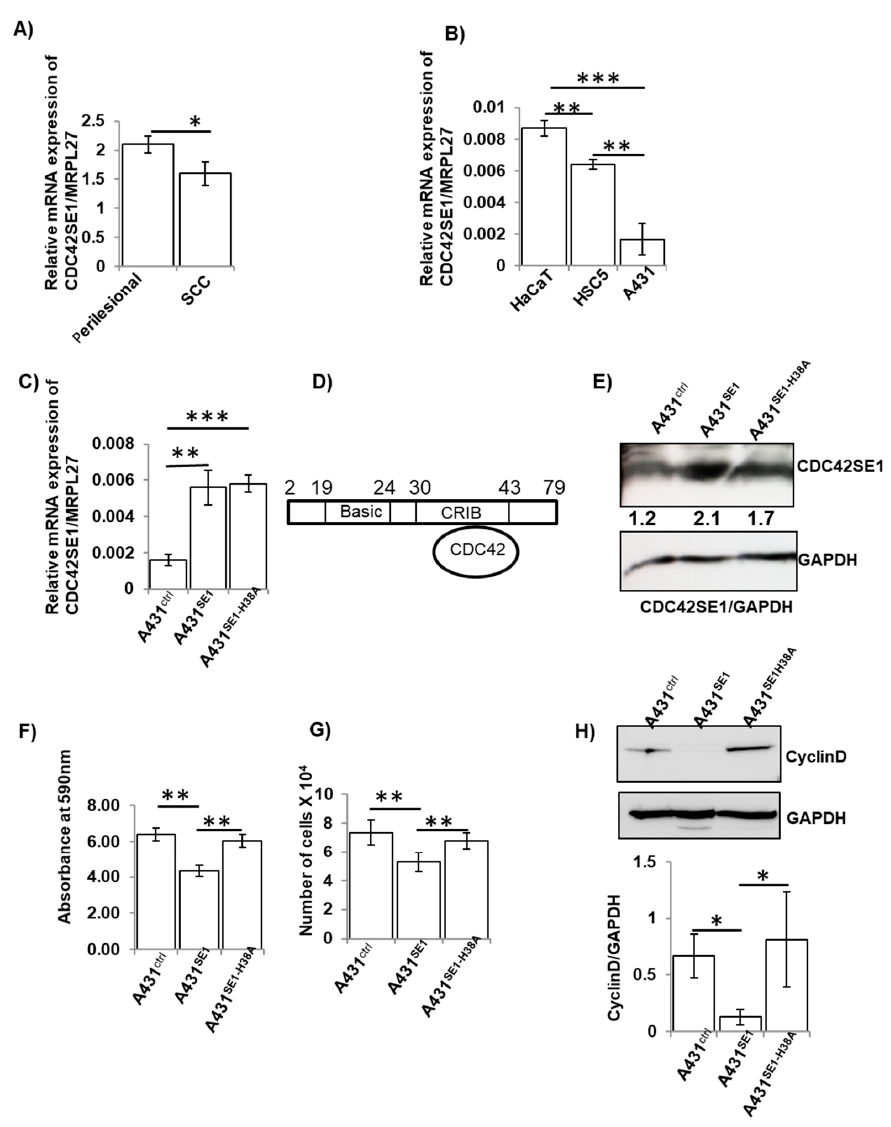
Figure 1. Expression of CDC42SE1 is reduced in SCC samples and exogenous expression of CDC42SE1 reduced cell proliferation. ( A ) Quantitative PCR analysis of expression of CDC42SE1 in SCC biopsies (n = 5) vs. the matched perilesional controls. Expression of MRPL27 was used to normalize. ( B ) Quantitative PCR analysis of expression of CDC42SE1 in HaCaT, HSC5, and A431 cells. Expression of MRPL27 was used to normalize. ( C ) Quantitative PCR analysis of expression of CDC42SE1 in A431 Ctrl , A431 SE1 , and A431 SE1-H38A cells (n = 3). Expression of MRPL27 was used to normalize. ( D ) Structure of CDC42SE1 with CDC42 binding. ( E ) Immunoblot analysis of CDC42SE1 expression in A431 Ctrl , A431 SE1 , and A431 SE1-H38A cells. GAPDH (Glyceraldehyde 3-phosphate dehydrogenase) were used as loading control (n = 3). ( F ) MTT assay and ( G ) cell proliferation assay of A431 Ctrl , A431 SE1 , and A431 SE1-H38A cells (n = 3). In total, 7500 cells were seeded in a 24-well plate and incubated at 37 ◦ C with 5% CO 2 . After 72 h incubation, cells were used for MTT assay and cell counting with hemocytometer. ( H ) Protein lysate from A431 SE1 , A431 SE1-H38A , and A431 Ctrl were subjected to western blot using anti-CyclinD1 and GAPDH was used as a loading control (n = 3). Note: *** p ≤ 0.001, ** p ≤ 0.01, * p ≤